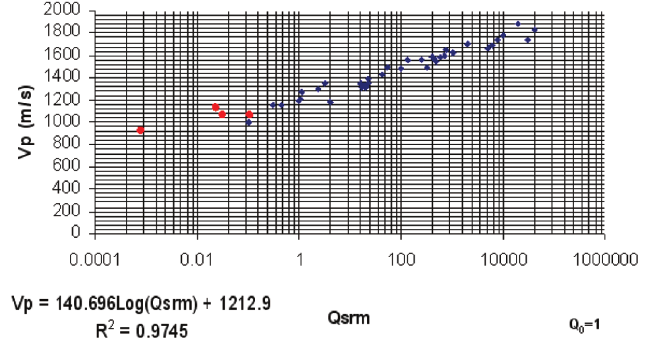
Fig. 8. P -wave velocity versus Q srm factor for coarse-grained massive calcarenite and sandstone of varying co- herence (Plio-Pleistocene), permeable due to